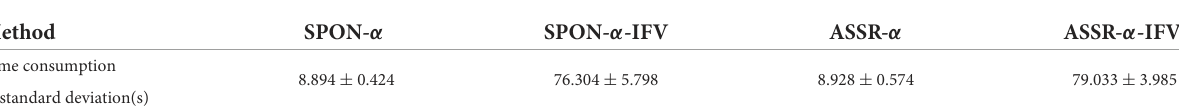
TABLE 1 Time consumption comparison of MSE